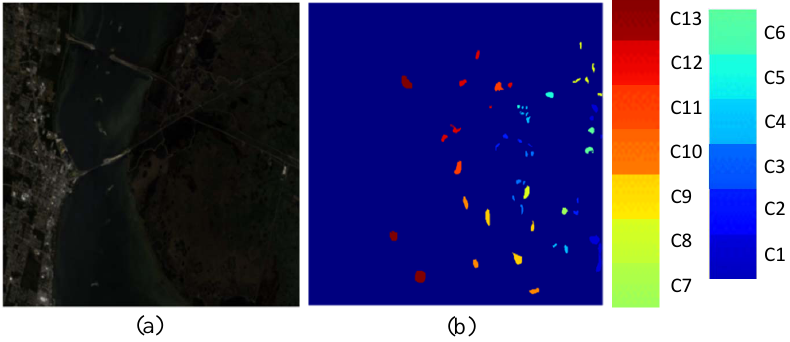
Figure 7. KSC dataset. ( a ) false-color composite of the KSC. ( b ) ground truth map containing 13 mutually exclusive land cover